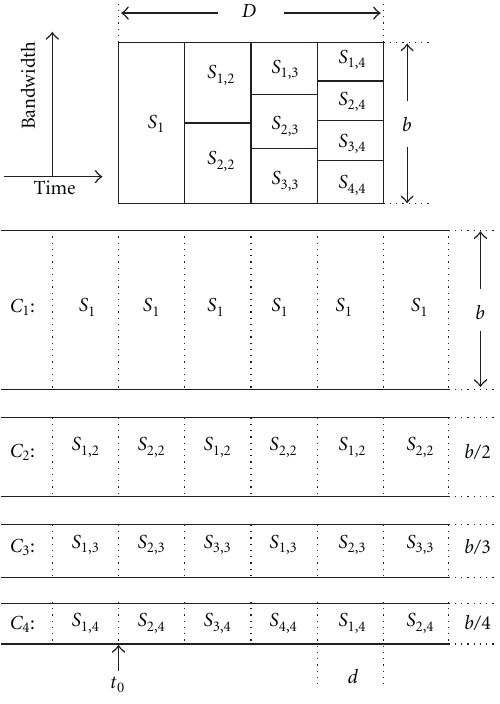
Figure 2: The HB scheme ( N =